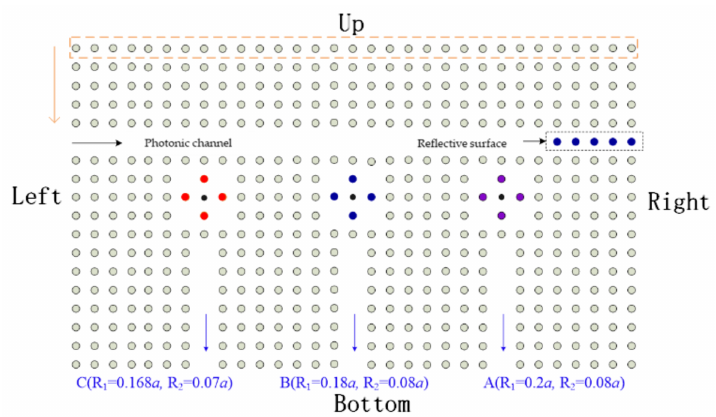
Figure 6. Schematic diagram of the photonic crystal filter scaling down from the